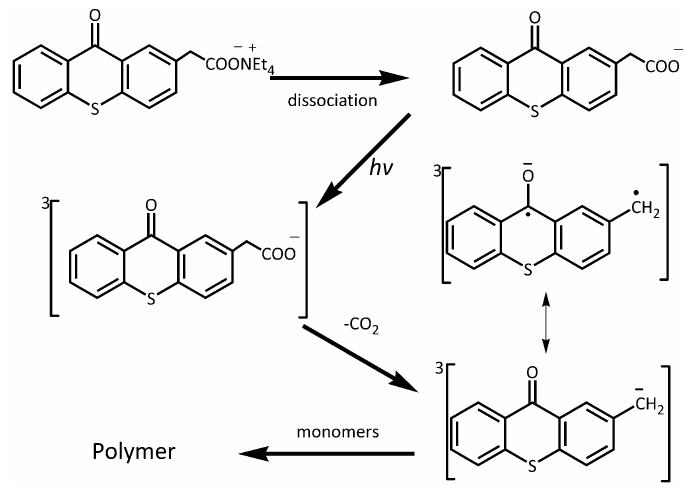
Figure 6. The proposed photoinitiated polymerization mechanism of the thioxanthone derivatives.